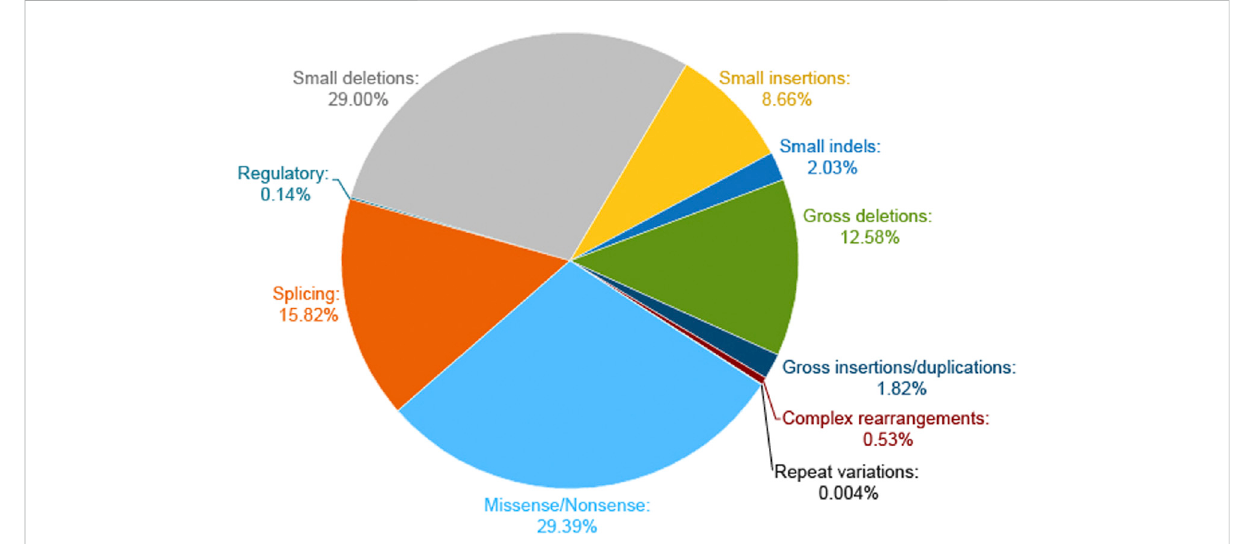
FIGURE 8 Pie chart of NF1 mutation types on the HGMD website. The micro lesions are made up of missense/nonsense, splicing, regulatory, small deletions, small insertions, and small indels. The gross deletions consist of gross deletions, gross insertions/duplications, and complex rearrangements of repeat